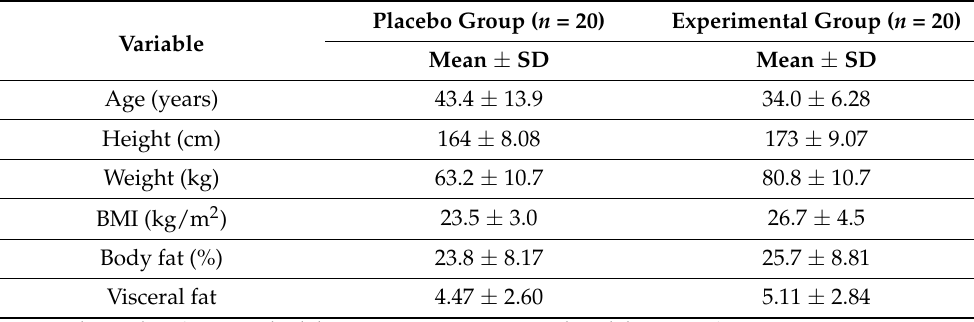
Table 2. Basic anthropometric and demographic characteristics of the sample.